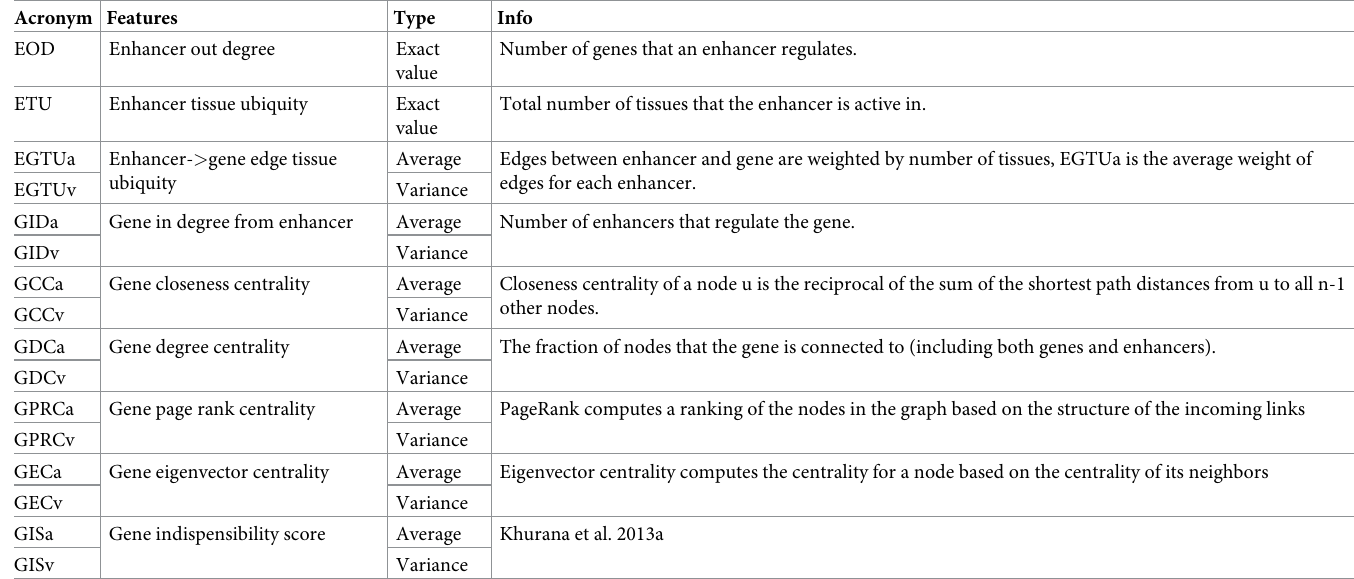
Table 1. Summary of network